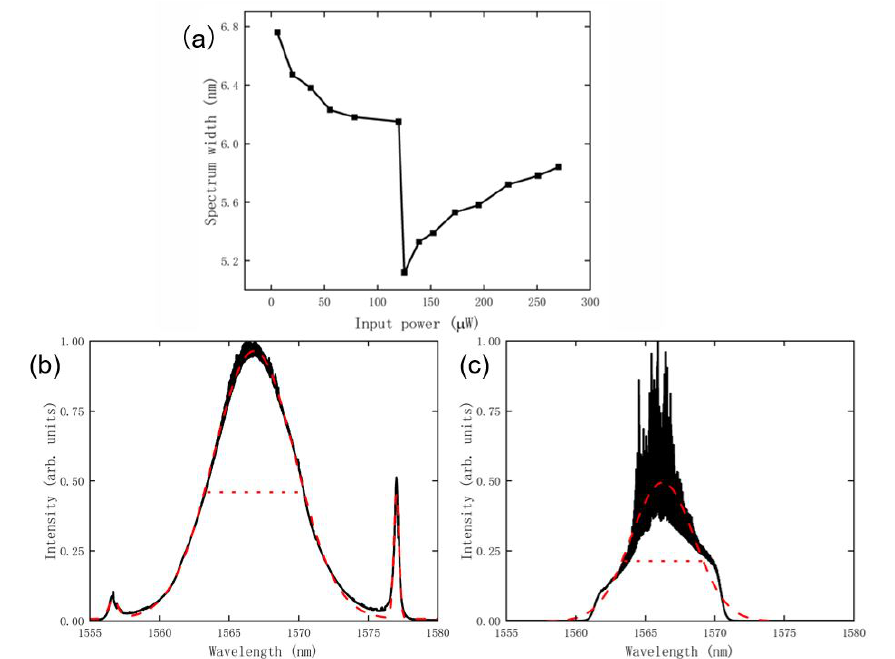
Figure 4. ( a ) The spectrum width of the output signal as the input signal power generated by the seed (left) laser is varied by the VOA; ( b ) the spectrum before the threshold at 5.742 µ W input power (here the red dotted line represents Gaussian fitting) with the spectral width 6.83 nm; ( c ) the spectrum after the threshold at 139 µ W input power and the corresponding spectral width 5.33